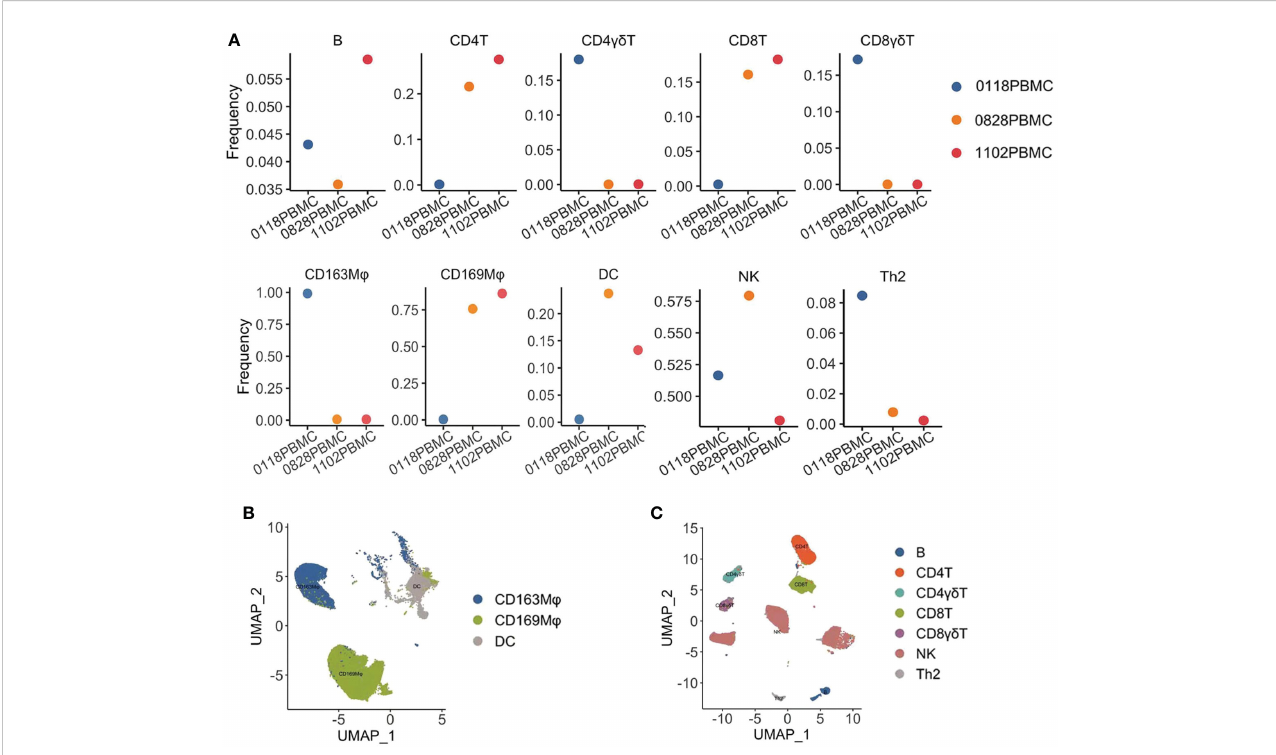
FIGURE 2 Cytometry by time-of- fl ight mass spectrometry (CyTOF) analysis of the immune state of the patient. (A) Frequencies of immune cell subsets in the peripheral blood mononuclear cell (PBMC) of a patient during treatment with pembrolizumab, 0118: before treatment, 0828: when the patient achieved PR, and 1102: when the patient ’ s disease had progressed. The frequencies of B cells, CD4 + T cells, CD8 + T cells, CD4 + gd T cells, CD8 + gd T cells, CD163 + macrophages, CD169 + macrophages, dendritic cells (DCs), natural killer cells (NKs), and T helper 2 cells (Th2) were analyzed. (B) Uniform Manifold Approximation and Projection (UMAP) displayed the distribution of myeloid cells from the PBMC in the patient. (C) UMAP displayed the distribution of lymphocytes from the PBMC in the